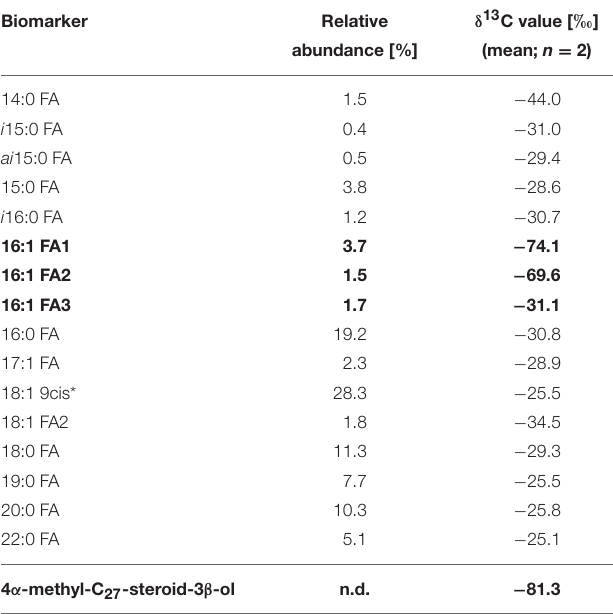
TABLE 2 | Biomarker composition and stable carbon isotope signatures of individual compounds.